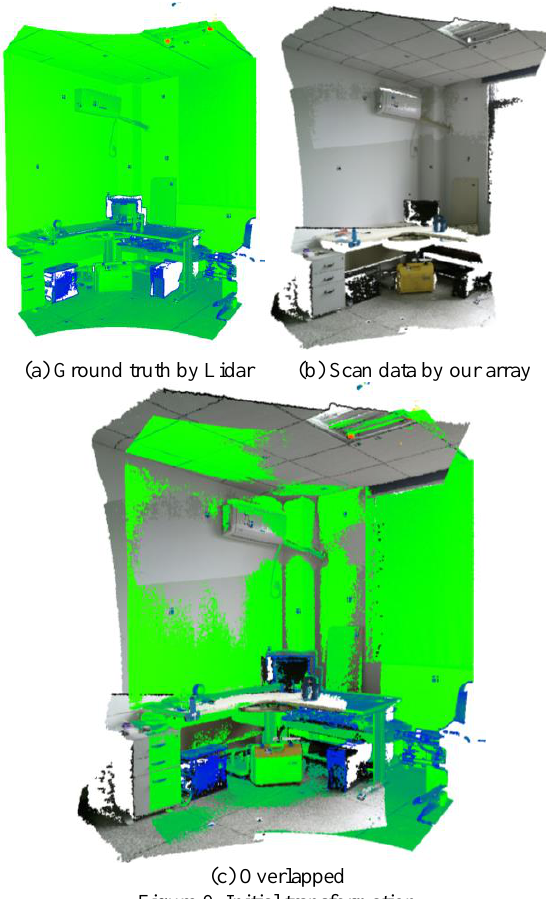
Figure 9. Initial transformation